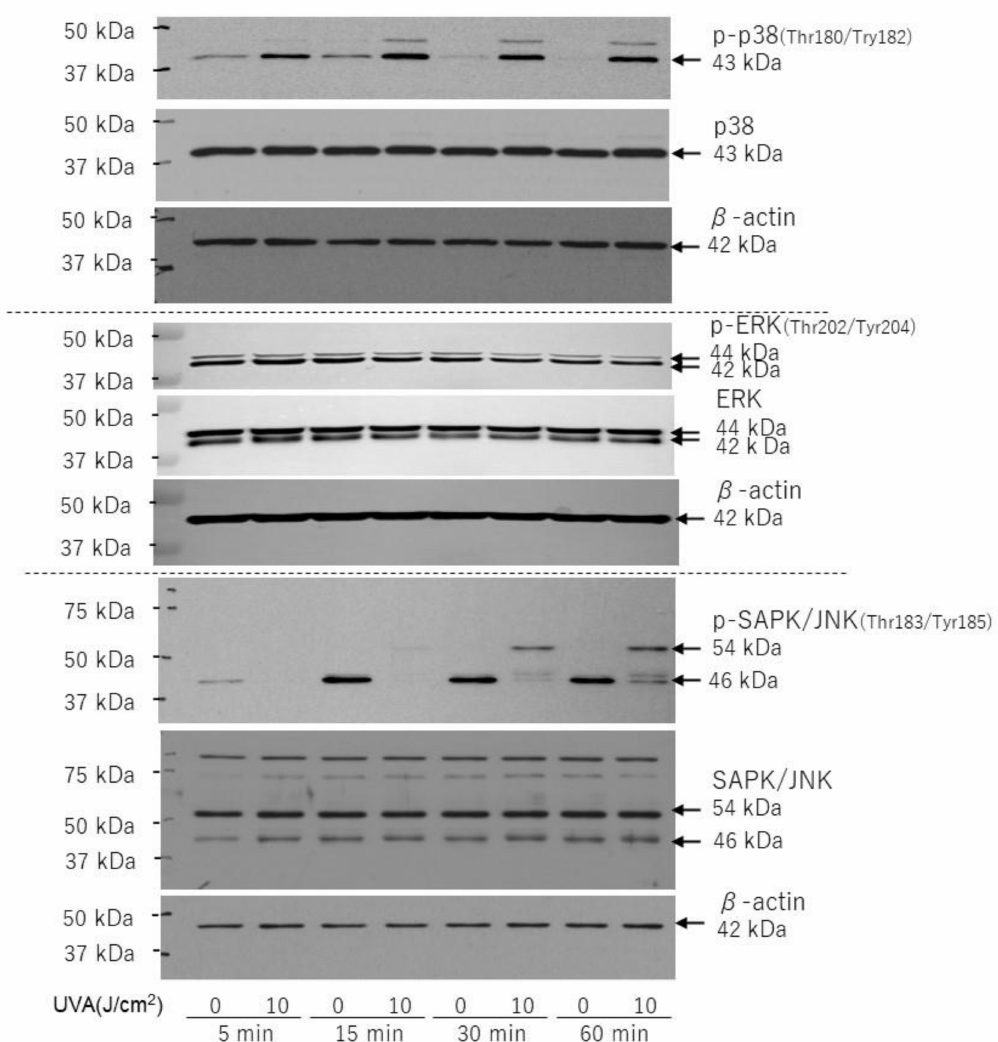
Figure 7. Effects of UVA on phosphorylation and protein levels of p38/ERK/JNK. HDFs were exposed to UVA at the indicated doses in culture and cell lysates prepared at the indicated times post-irradiation were subjected to western blotting as described in the Materials and Methods section. Representative immunoblots from three independent experiments are